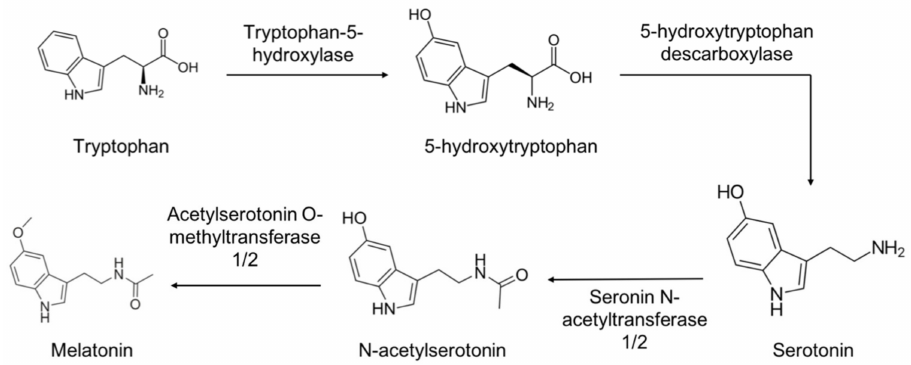
Figure 2. Synthesis pathway of melatonin in zebrafish. Tryptophan is uptake by the pinealocyte and hydroxylated by the enzyme tryptophan-5-hydroxylase, generating 5-hydroxytryptophan which is decar- boxylated by 5-hydroxytryptophan decarboxylase yielding serotonin. Serotonin is acetylated by AANAT1 or 2, originating N-acetylserotonin. Finally, serotonin is methylated by ASMT1 or 2 producing